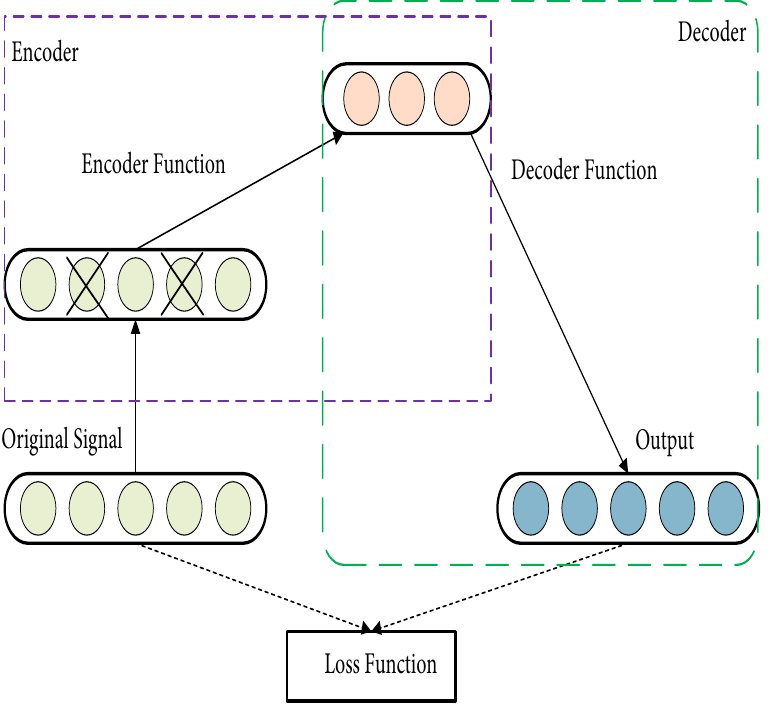
Figure 2. Denoising autoencoder network